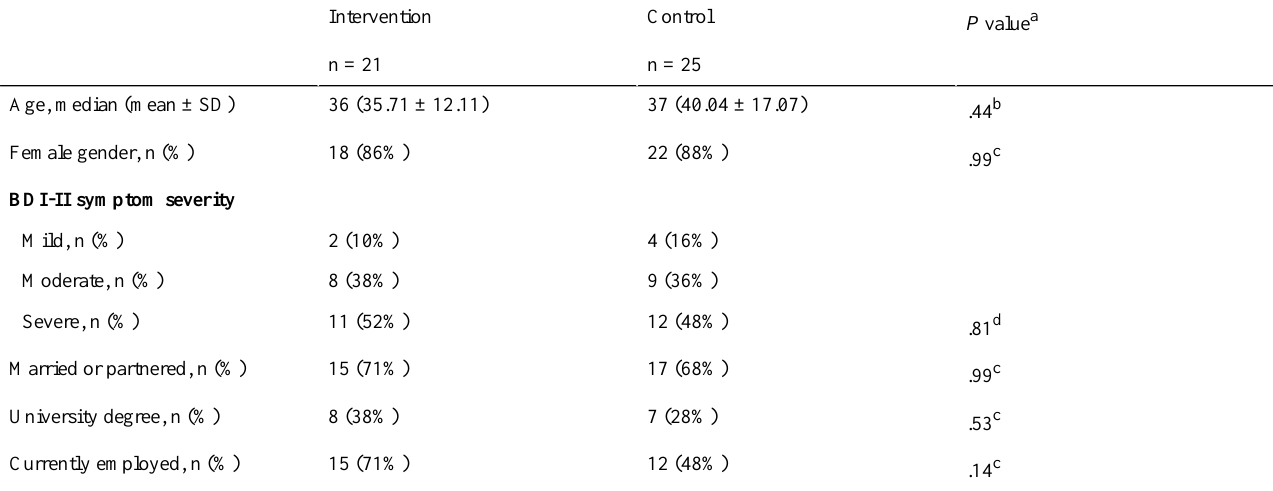
Table 2. Group characteristics at Time 0